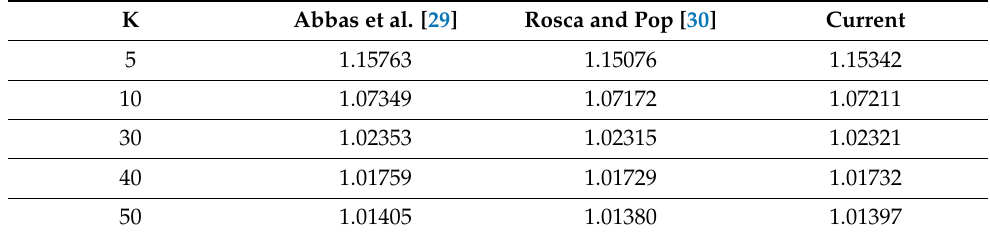
Re b 1 n + 1 C fr with published 2